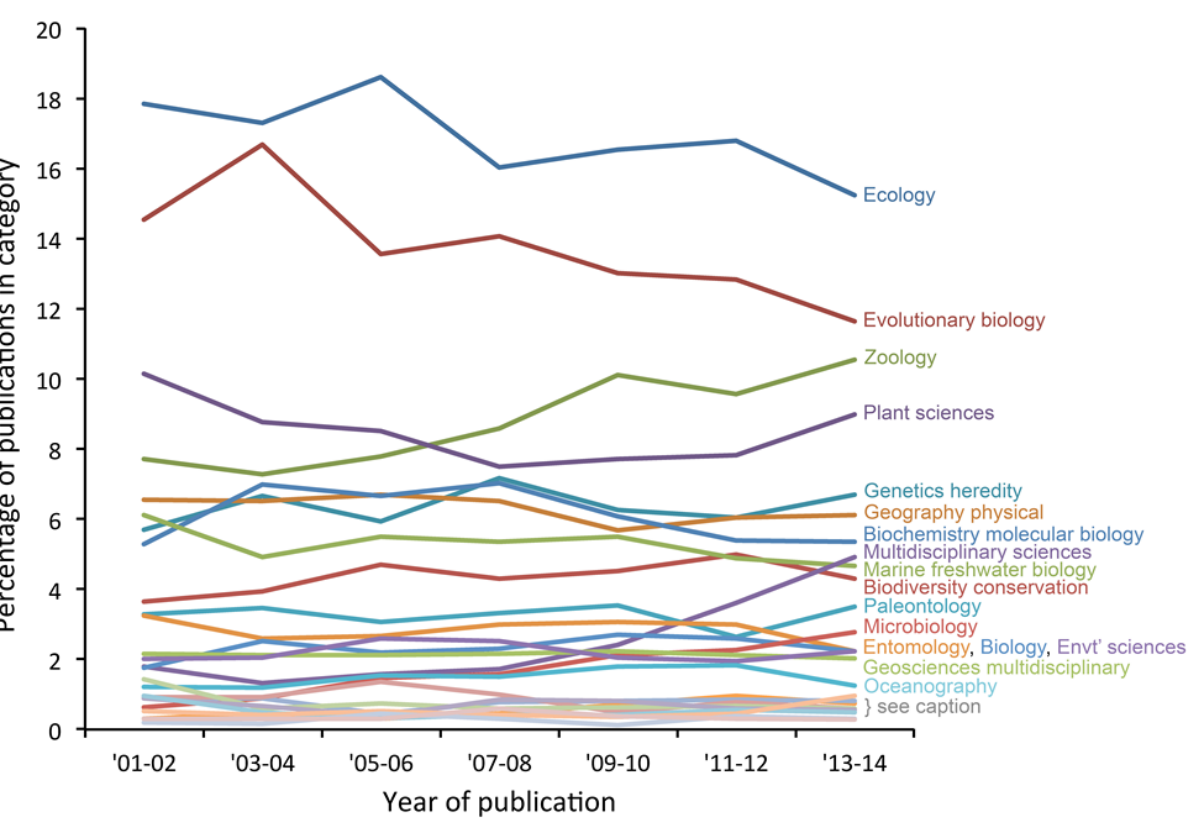
Figure 6. Percentage of biogeography publications in biennial periods since 2000 classified into each of 26 research categories by Thomson Reuters in the Web of Knowledge database. Articles were identified by the topic word search “biogeography” in the Science Citations Index–Expanded database. The categories shown are those present in the same analysis for the first horizon scan of biogeography (Dawson et al. 2013) and represent the top 26 categories in 2011–2012 that also were recorded in all prior biennial periods. The least frequent nine categories from more to less common, are: geology, mycology, biotechnology applied microbiology, ornithology, parasitology, fisheries, forestry, anthropology, limnology. The analysis for 2013–2014 includes 4588 papers published as of 30 November 2014 (more recent analysis is not possible because Thomson Reuters subsequently changed their research categories, e.g., lump- ing Environmental Sciences and Ecology). The number of publications in each preceding biennial period (and the per- centage this represents of total biogeography publications each period) is, respectively, 1682 (97.9%), 1949 (98.4%), 2517 (98.1%), 3153 (97.7%), 3966 (97.5%), 4463 (96.7%), 4773 (94.9%) (Dawson et al. 2013). Note that categories are journal-level metrics, not article-level metrics. Simply for context, the four main biogeography journals are catego- rized as follows: Diversity and Distributions = biodiversity conservation & ecology; Ecography = biodiversity conserva- tion & ecology; Global Ecology and Biogeography = geography (physical) & ecology; Journal of Biogeography = geog- raphy (physical) &